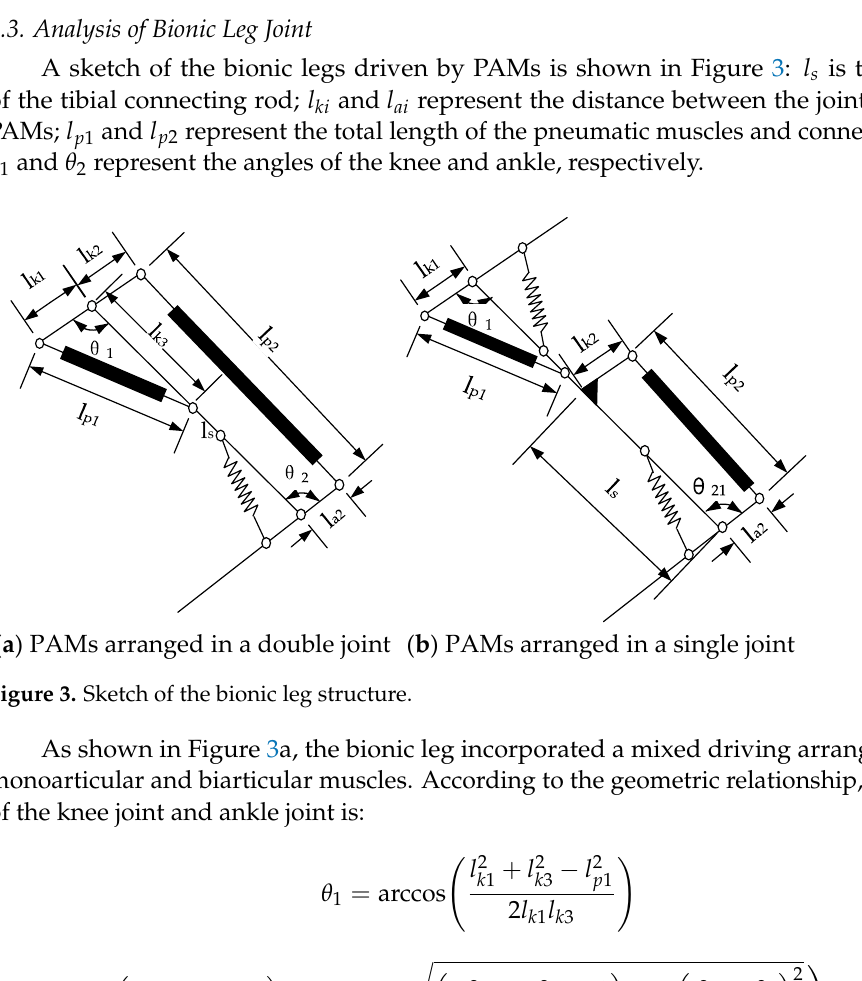
Figure 2. Bionic leg driven by biarticular PAM and monoarticular PAM.